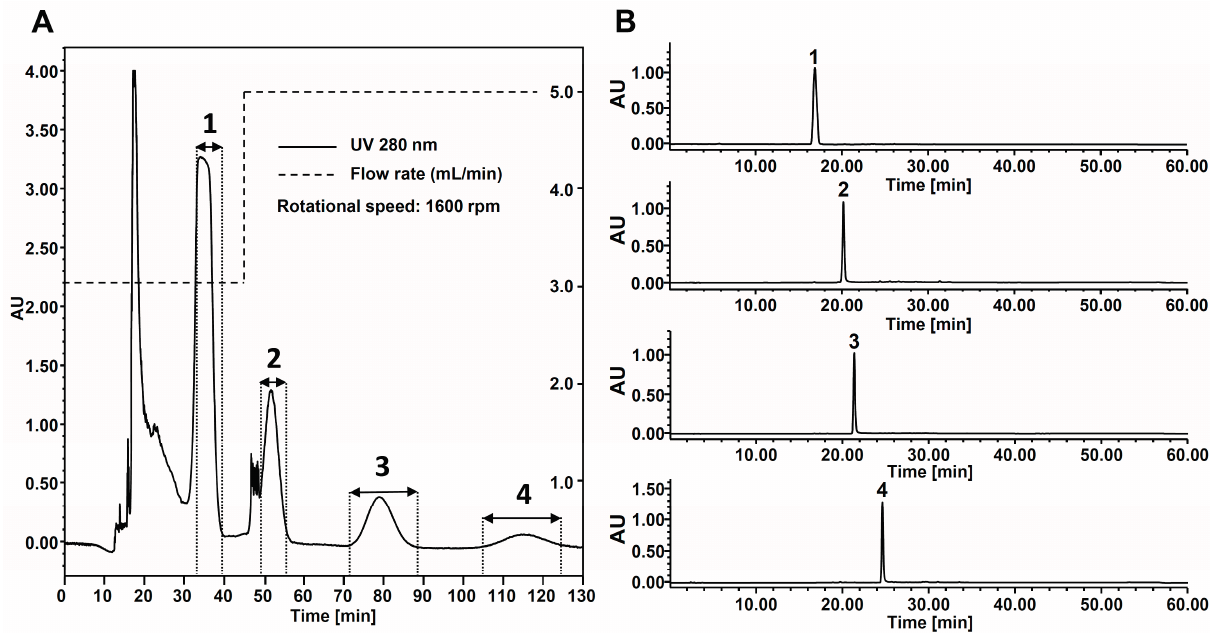
Figure 4. ( A ) Preparative HPCCC separation of the acetone-soluble extract of fermented C. sinensis leaves using an n -hexane–ethyl acetate–methanol–water (1:9:1:9, v/v ) system. ( B ) HPLC chromatograms of compound 1 – 4 isolated by HPCCC. Peaks 1 : caffeine, 2 : ( −